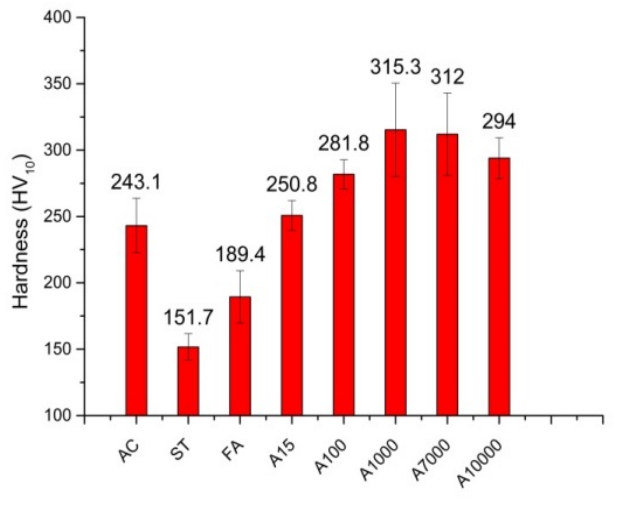
Figure 15. Hardness data of samples in this study.